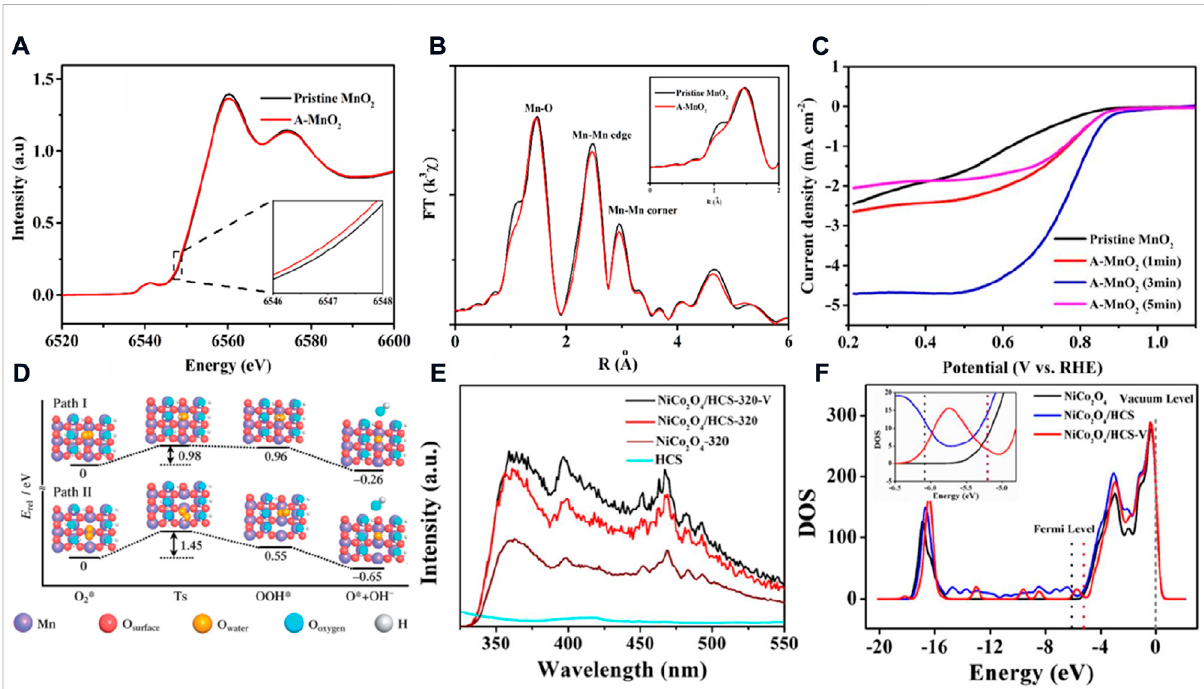
FIGURE 3 (A) Mn K-edge XANES spectra and (B) magnitude of k 2 -weighted Fourier transforms of Mn K-edge EXAFS spectra for the treated MnO 2 and the pristine MnO 2 ; (C) ORR performance of the treated MnO 2 with different times and the pristine MnO 2 (Jiang et al., 2019). (D) Energy pro fi les and con fi gurations of the ORR on MnO 2 surfaces with one 1) and two 2) oxygen vacancies (Cheng et al., 2013). (E) Photoluminescence spectra and (F) density of states of the selected catalyst and comparison sample (Yuan et al.,